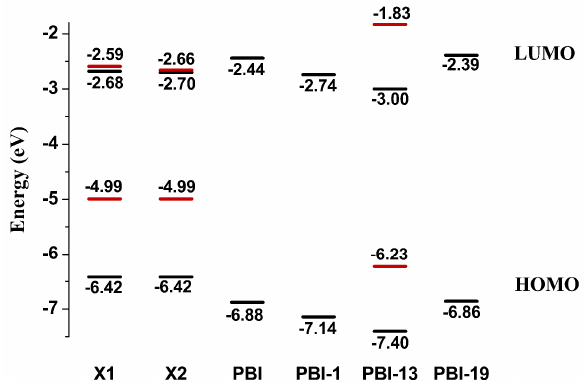
Figure 4. Evaluation of the computed HOMO and LUMO energies for PDI-BI , PDI-BI-1 , PDI-BI-13 , and PDI-BI-19 as well as the HOMO and LUMO energies for X1 and X2 at the CAM-B3LYP6-31G(d)//PBE0/6-31G(d) level. The black line represents singlets, and the red line represents triplets.